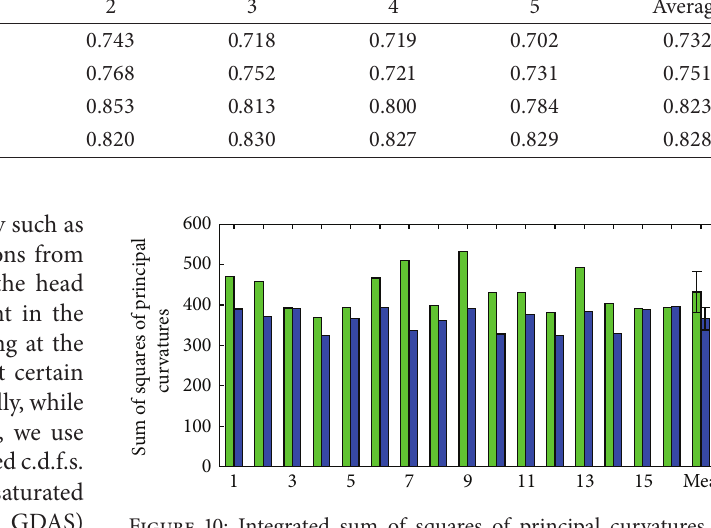
Figure 10: Integrated sum of squares of principal curvatures is shown for the 16 patients examined, as well as means and standard deviations. Green/left of pair: typical landmark matching; blue/right of pair: GDAS landmark